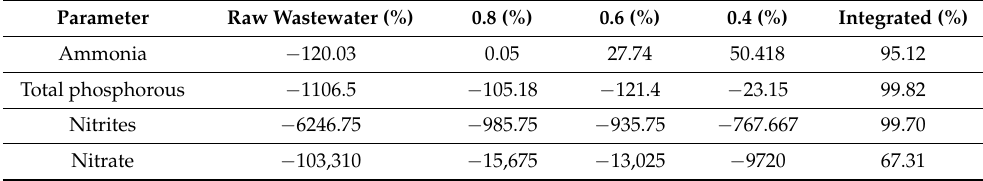
Table 5. Percent compliance from raw wastewater and treated effluent.